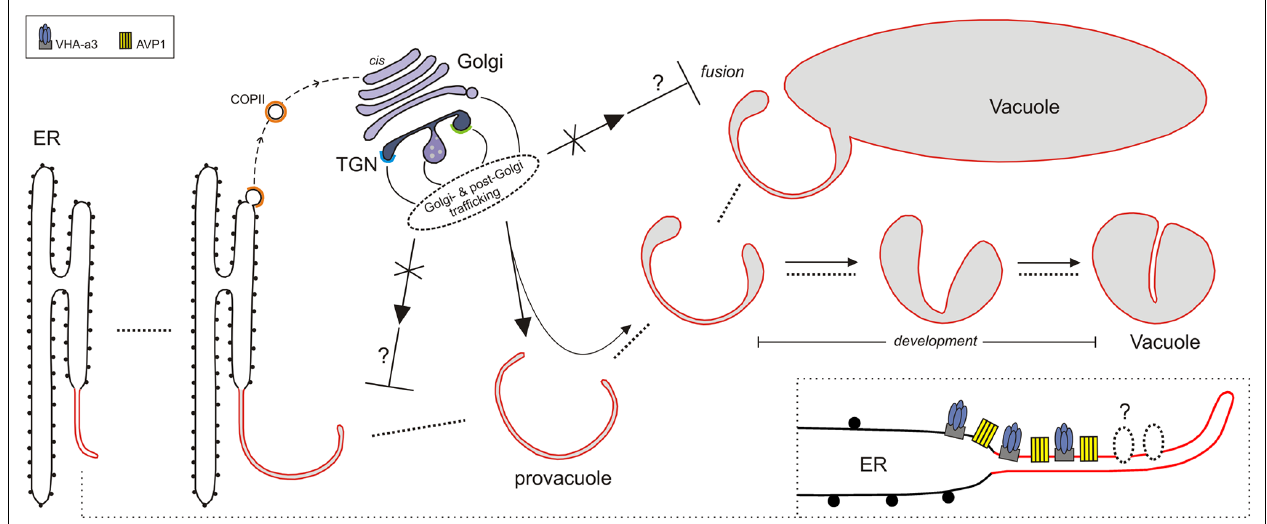
delivery of soluble cargoes (e.g., acid proteases) and tonoplast-resident proteins that exit the ER with COPII-coated vesicles (dashed arrow). Provacuoles can also fuse with already developed vacuoles ( fusion ). Impairment of Golgi- and post-Golgi trafficking (crossed arrows) leads to aberrant multilayered provacuoles.This observation could be explained if impairment of Golgi- and post-Golgi trafficking would interfere ( ⊥ ) with the process of provacuoles-release from the ER, or with the fusion between provacuoles and